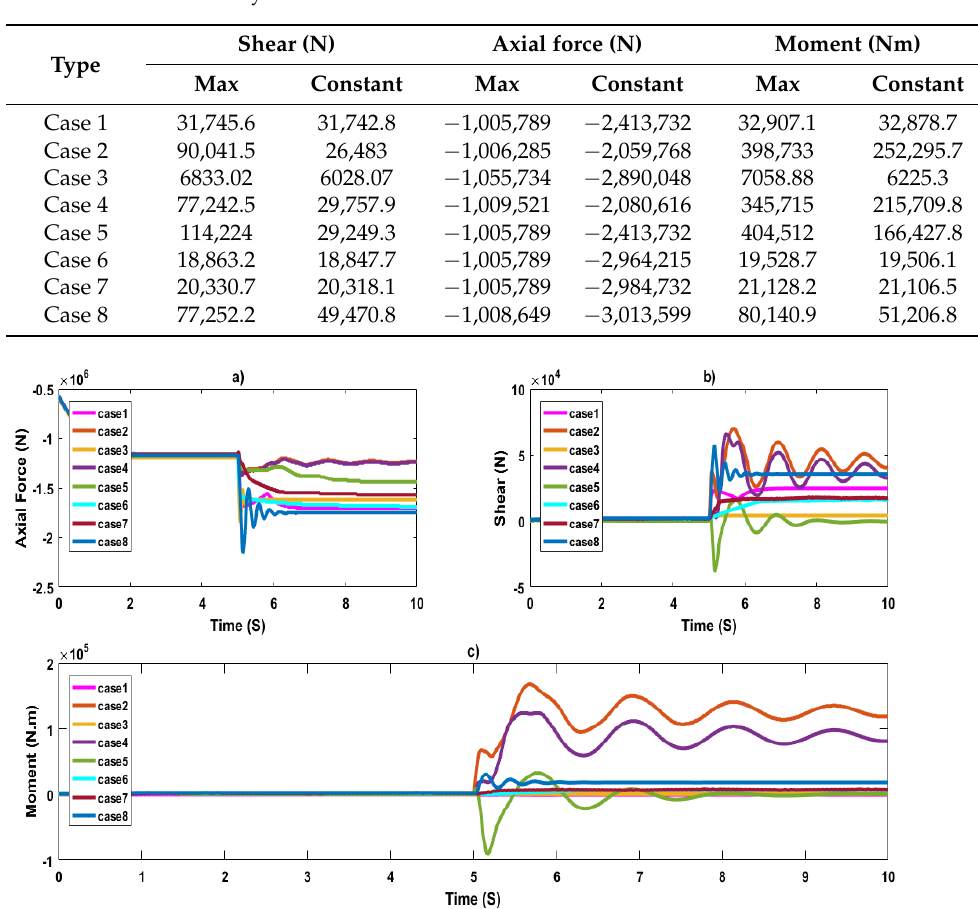
Figure 22. Column behavior after column removal in story six: ( a ) axial force, ( b ) shear, and ( c ) moment.